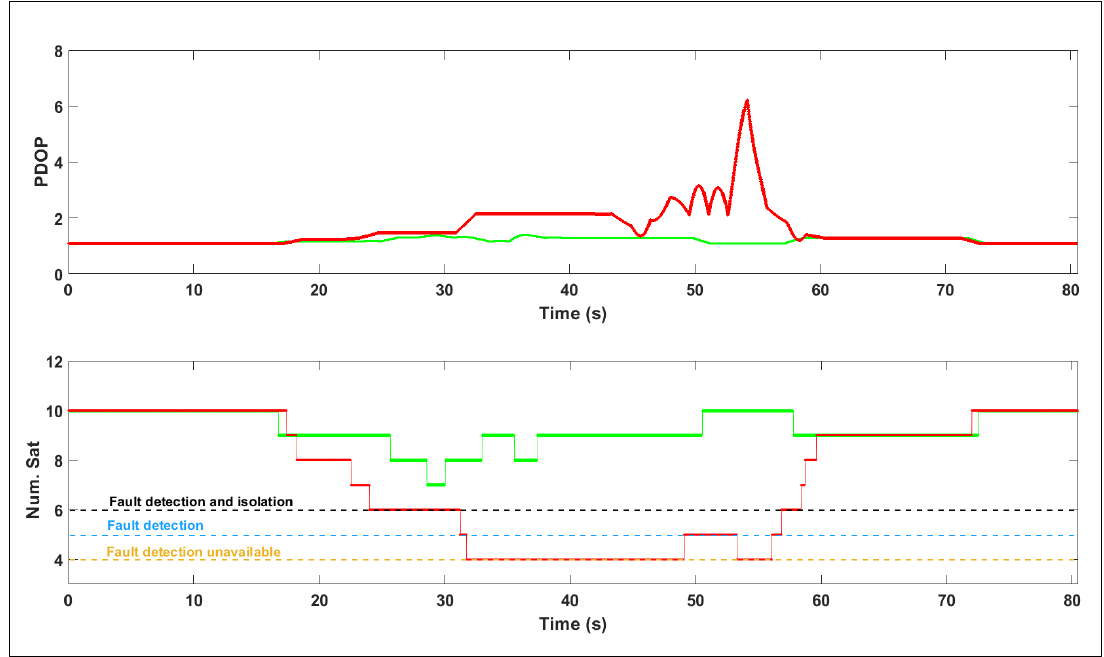
Figure 13. PDOP and Number of visible satellites for A* and Nav-A* paths.